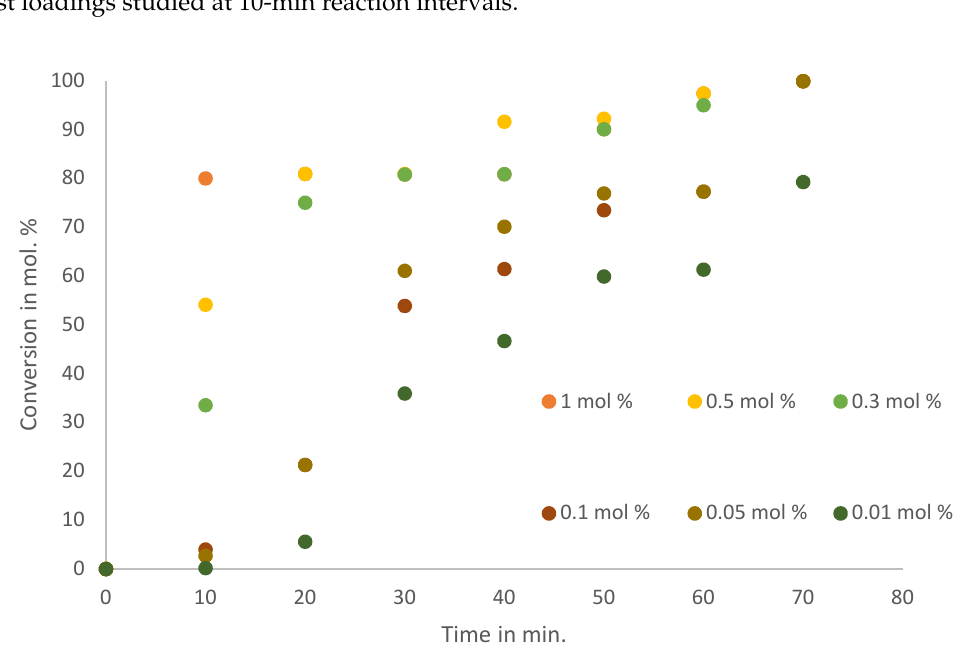
Figure 5. Reaction profiles at 10-minute intervals of the catalytic reactions with various loadings of Pd.